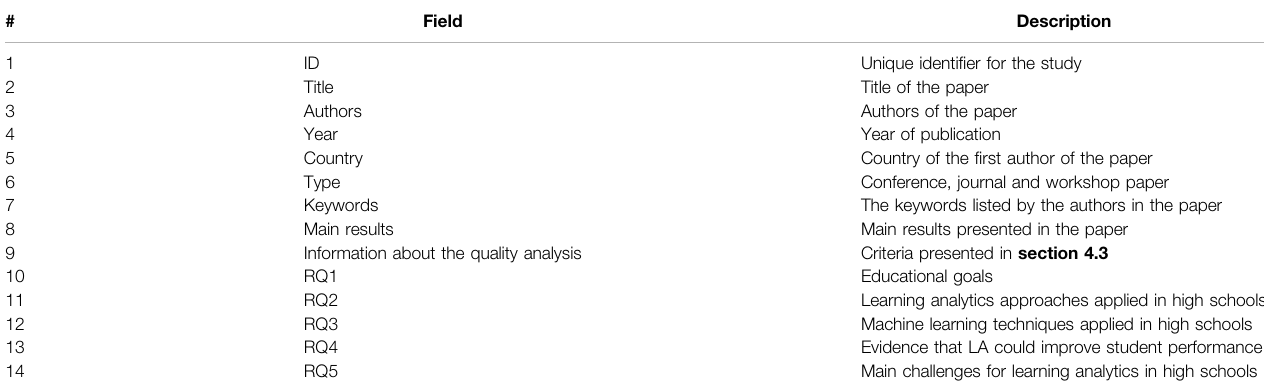
TABLE 4 | Information extracted from the papers included in the systematic literature review .